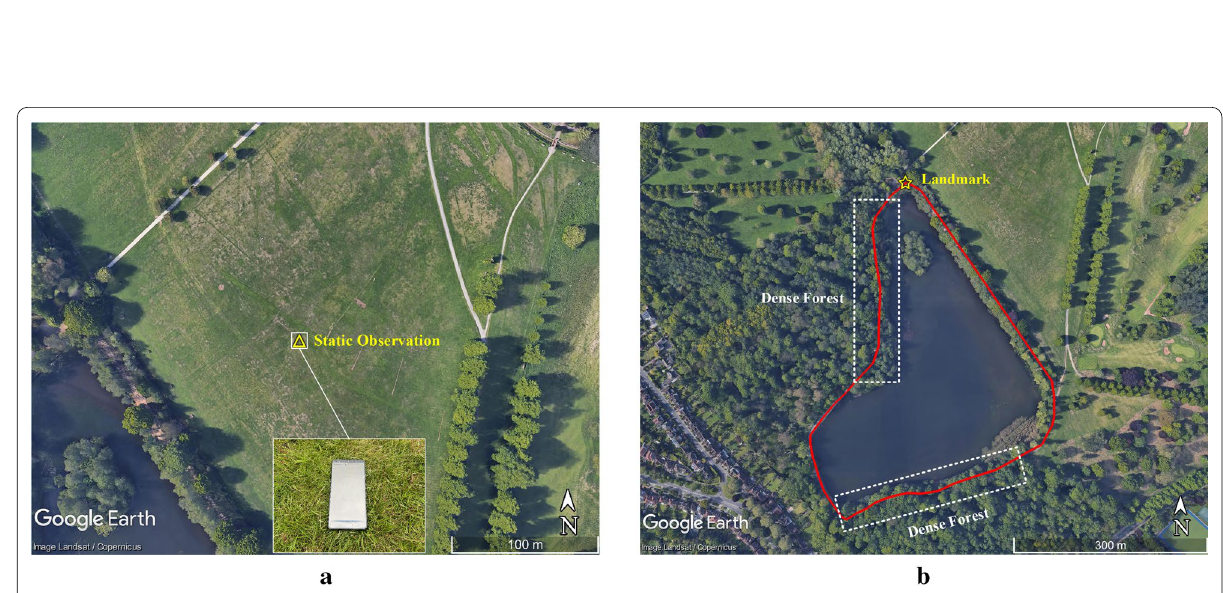
Fig. 6 Locations for a static and b kinematic smartphone GNSS data collection and their surrounding